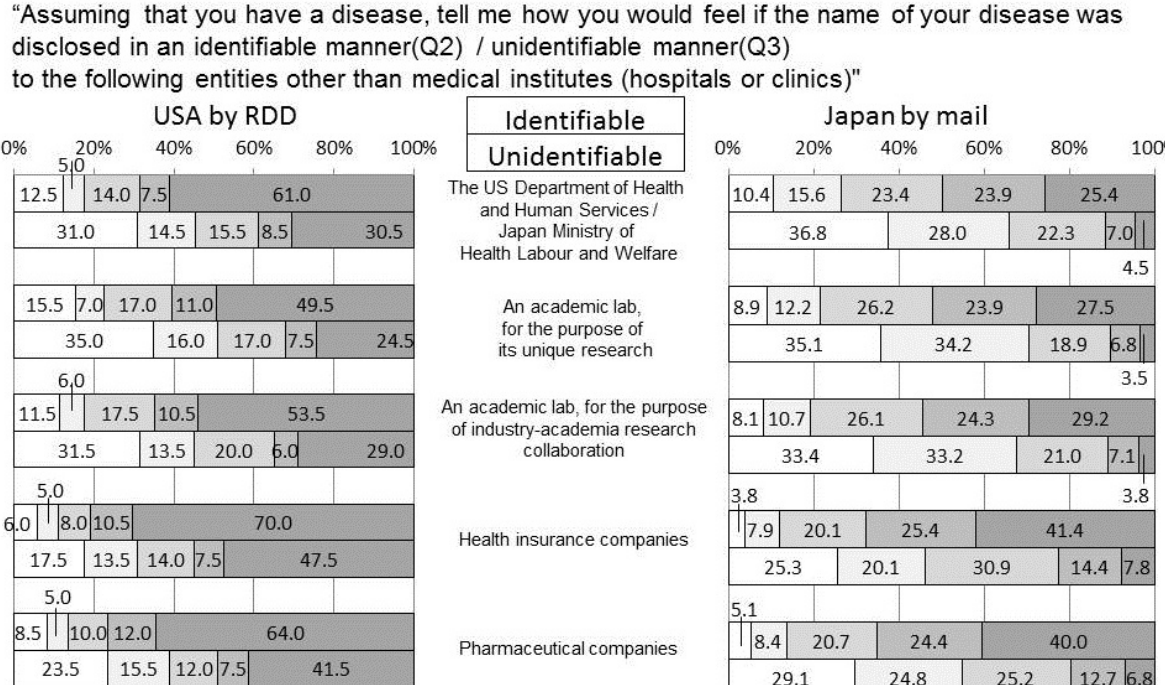
Figure 2. How would you feel if, without your consent, the name of your disease was disclosed to these organizations in an identifiable/unidentifiable